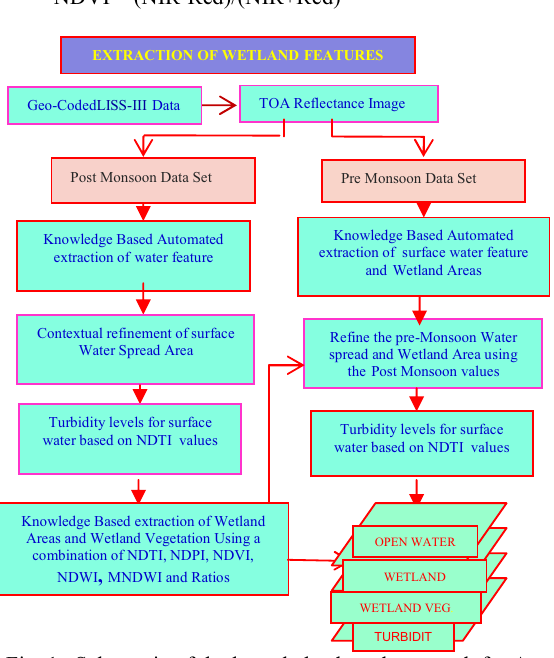
Fig. 1 Schematic of the knowledge based approach for Auto- mated Wet land Feature Extraction